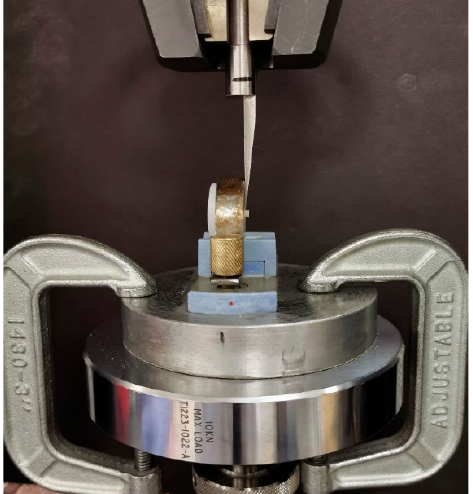
Figure 1 . A sample loaded in the universal testing